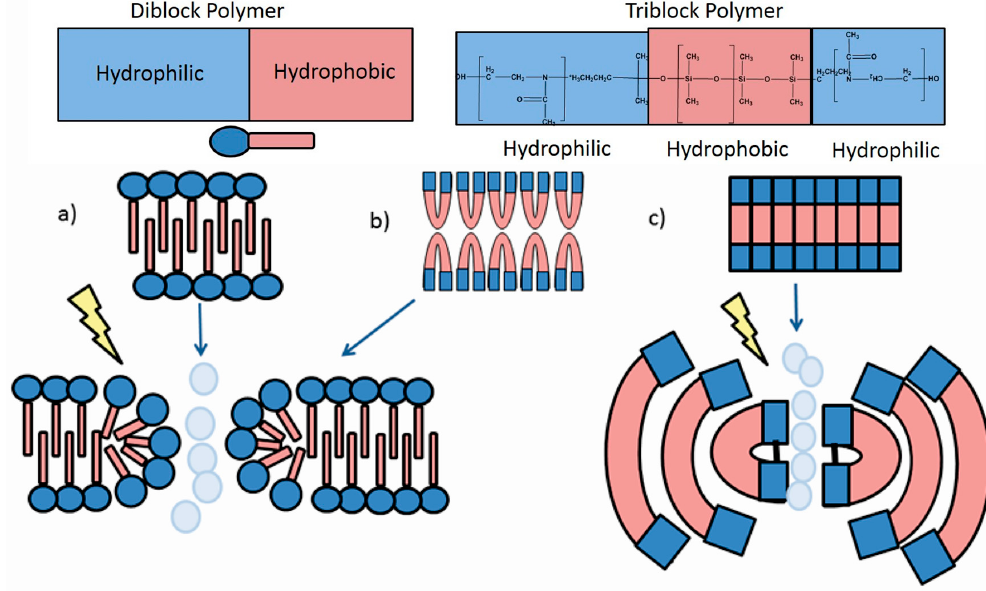
Figure 3. Schematic to show the hypothesis of the formation of pores by electroporation. ( a ) The case for a lipid or di-block polymers. The PMOXA–PDMS–PMOXA tri-block membrane could self-assemble in one of two ways, using electroporation (depicted by electric flash) to allow water (represented by blue droplets) to enter the bilayer; ( b ) A schematic of the folded over hairpin-like membrane form analogous to a more traditional bilayer, which can then follow the same mechanisms for electroporation as ( a ); and ( c ) the tri-block assembly as a monolayer. Upon electroporation, this bends over on it-self to shield the hydrophobic region of the structure.